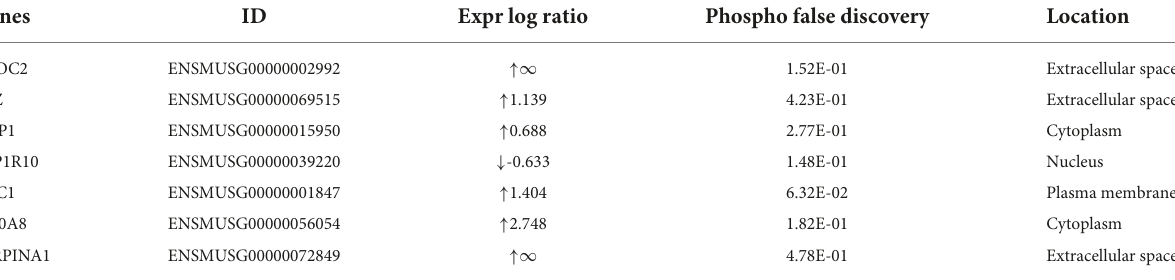
TABLE 3 IPA analysis identifies activation of pathway for production of nitric oxide and reactive oxygen species in macrophages in MYH6-Cre-BDNF − / − heart (activation z -score = 2.65; p =